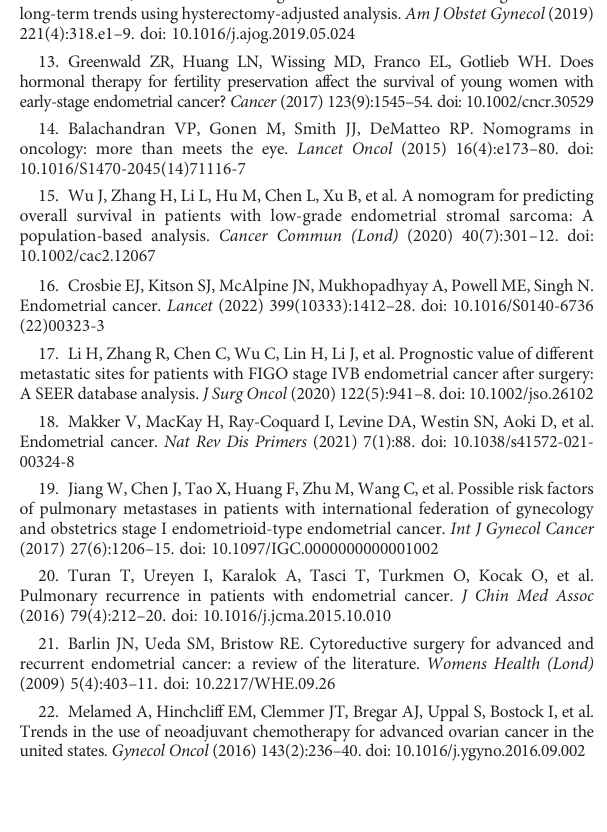
cohort. DCA curves of 1-year (C) and 3-year (D) overall survival (OS) in the validation cohort. SUPPLEMENTARY FIGURE 2 Dynamic web version of the nomogram. The left side of the interface is the corresponding data, and the right side is the ‘ Survival Plot ’ , ‘ Predicted Survival ’ , Numerical Summary ’ and ‘ Model Summary ’ modules.